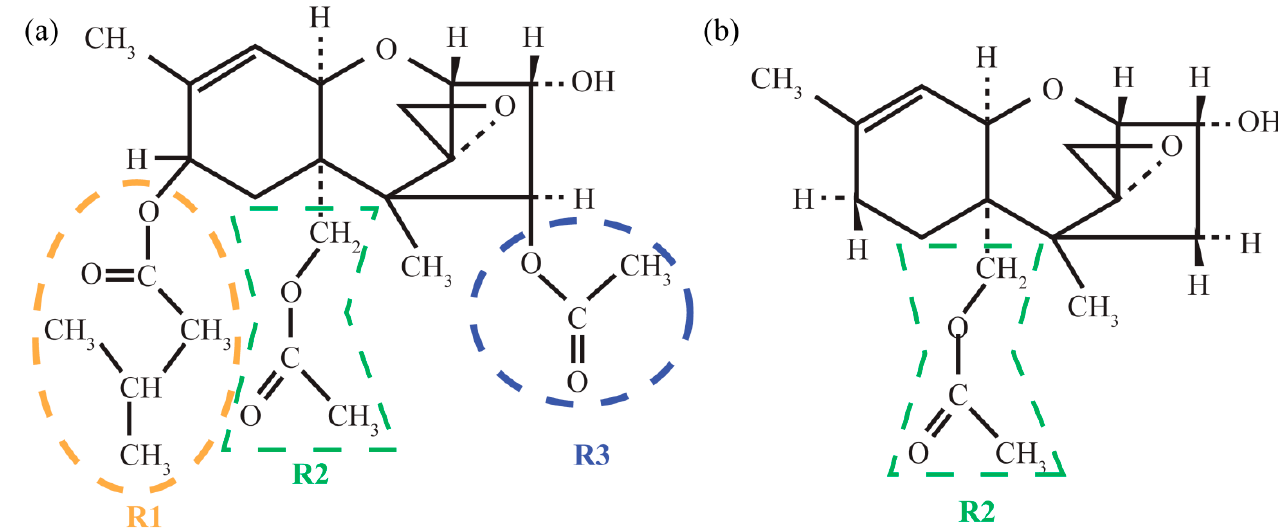
Figure 1. Schematic representation of T-2 ( a ) and 3-deacetylcalonectrin ( b ) toxin molecules. Orange, green and blue contours highlight the R1, R2 and R3